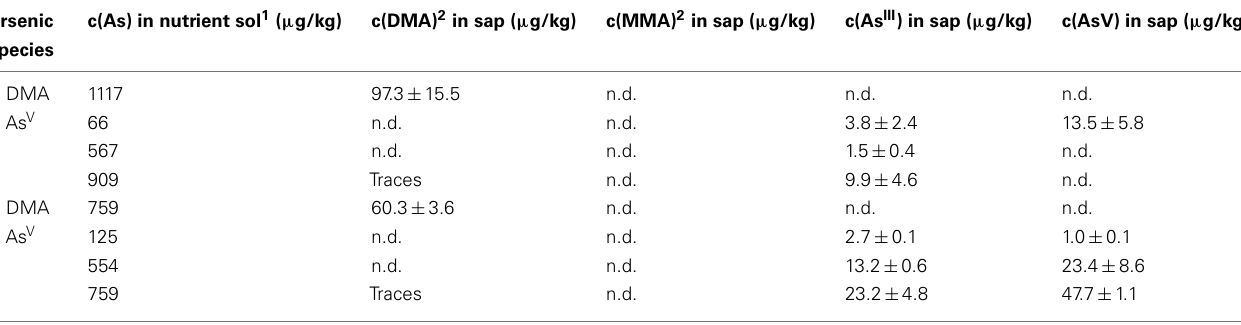
Table 2 |Arsenic concentration and speciation of sap samples of plant set B and plant set C after challenge with 1000 μ gkg − 1 DMA, 100, 500, and 1000 μ gkg − 1 As V for 24h.